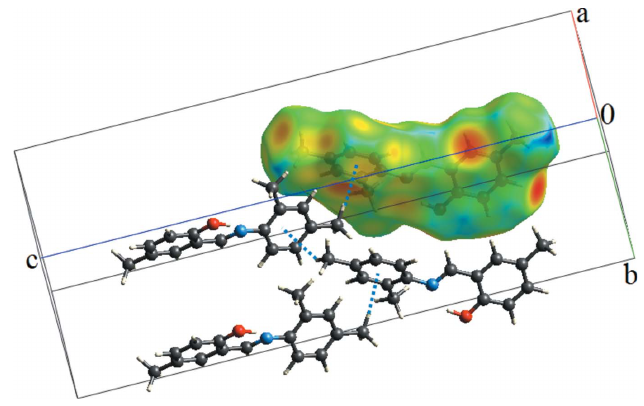
Figure 1 The molecular structure of the title compound, with atom labelling. Displacement ellipsoids are drawn at the 40% probability level. Dashed lines denote the intramolecular O—H (cid:2)(cid:2)(cid:2) N hydrogen bond forming an S (6) ring